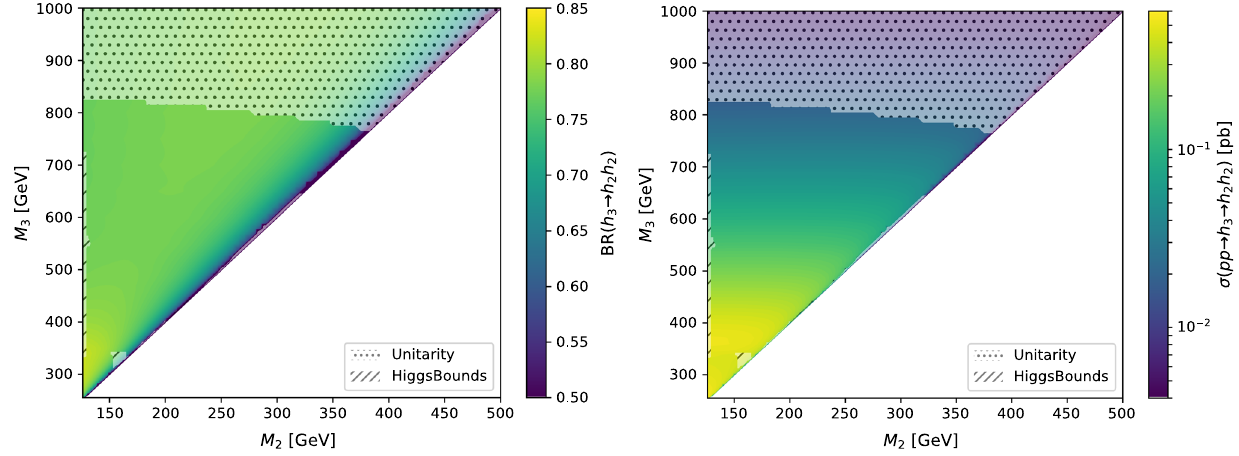
Fig. 14 Benchmark plane BP6 for the decay signature h 3 → h 2 h 2 with h 125 ≡ h 1 , defined in the ( M 2 , M 3 ) plane. The color code shows BR ( h 3 → h 2 h 2 ) (left panel) and the signal rate for pp → h 3 → h 2 h 2 (right panel). The shaded region at large M 3 is excluded by perturbative